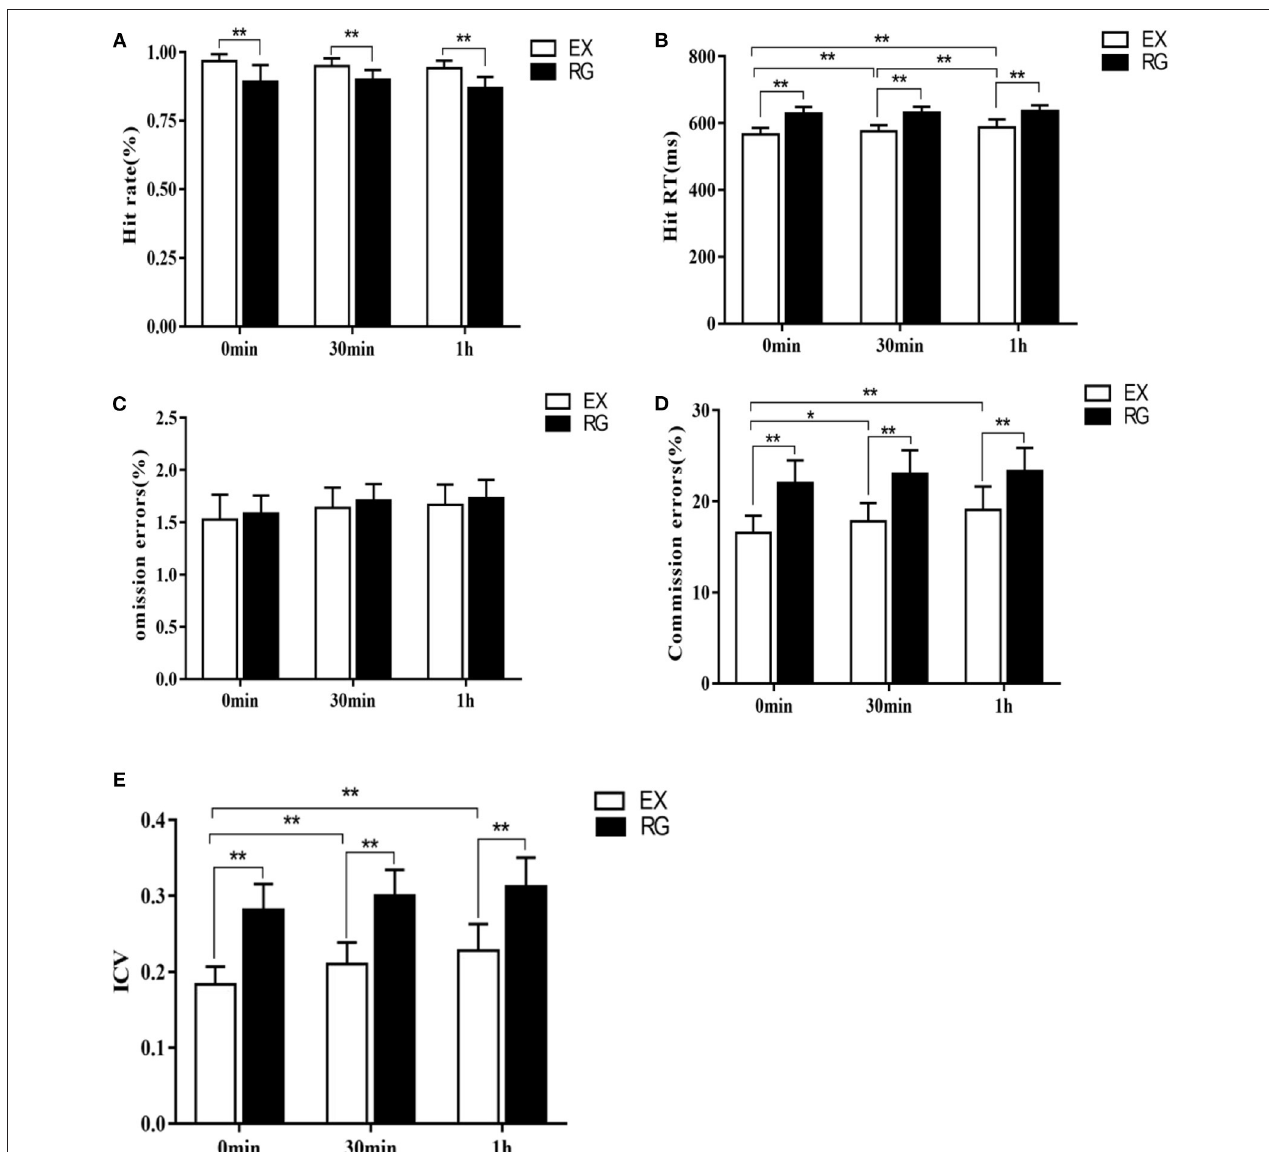
FIGURE 4 | Comparison of changes in each index of Go/Nogo task at different time points after exercise intervention. (A) Change in hit rate, (B) Change in RT, (C) Change in the number of omission errors, (D) Change in the number of commission errors, and (E) Change in ICV. * p < 0.05, ** p <